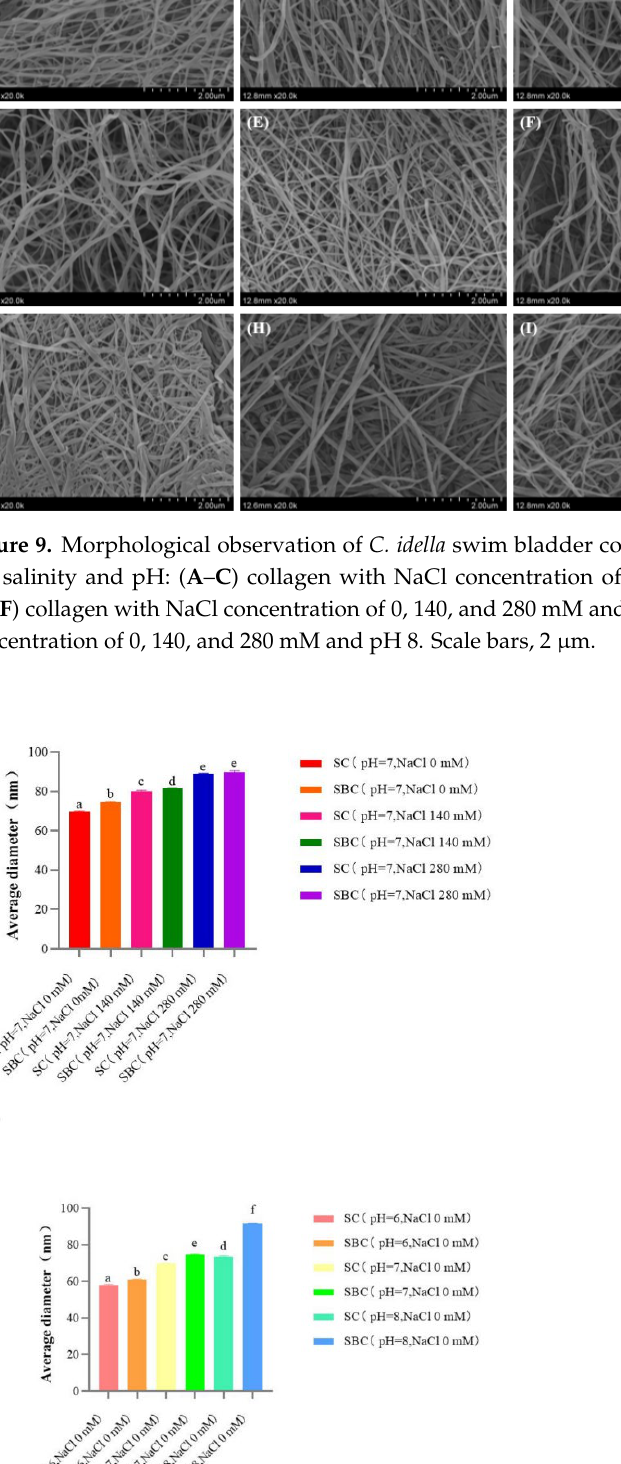
Figure 10. Effects of salinity and pH on the average diameter of C. idella ( A ) skin collagen (SC) and ( B ) swim bladder collagen (SBC) fibrils ( n = 200). a,b,c,d,e,f represents significant differences ( p < 0.05). Table 2. Average diameter of C. idella skin collagen (SC) and swim bladder collagen (SBC) fibrils under different salinity and pH conditions ( n = 200).